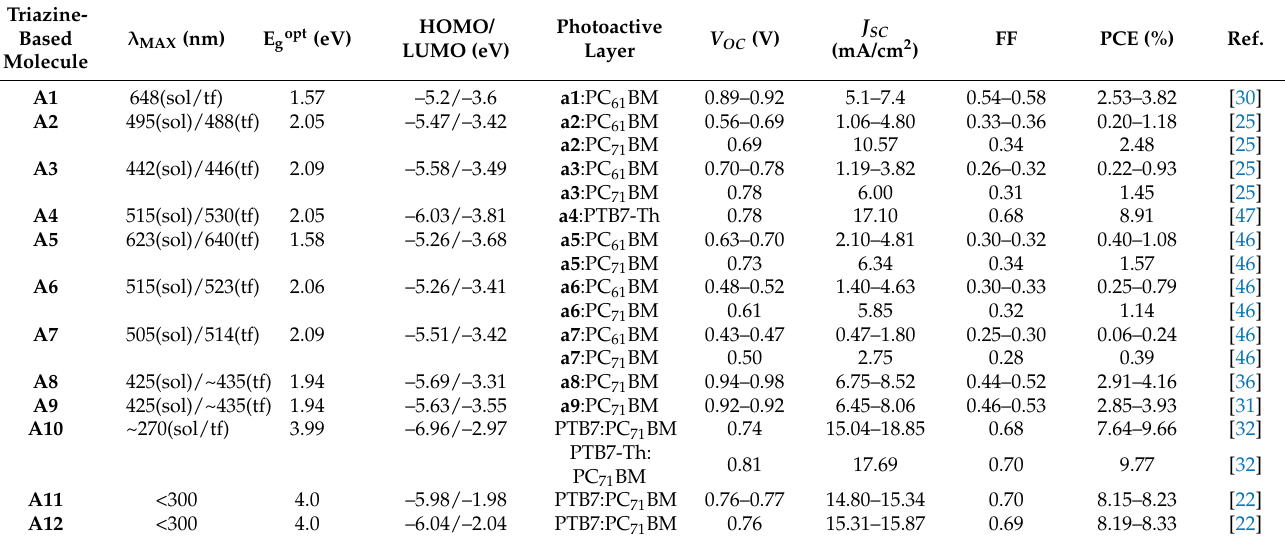
Table 1. Optoelectronic properties and performance characteristics of triazine-based SSCMs.